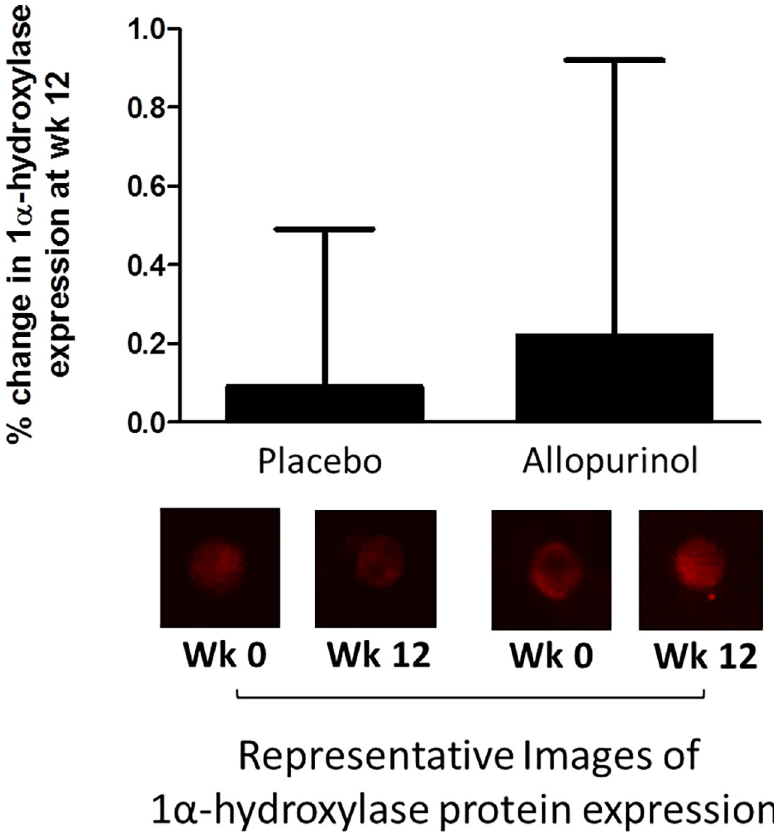
Fig 1. Treatment with allopurinol for 12 weeks was not associated with increased expression of 1 α - hydroxxylase protein compared to placebo (p value for generalized linear mixed model = 0.59). The figures represent change in the expression of the protein from baseline by study group. Values for each sample were reported as arbitrary units and represent ratios of endothelial cell protein expression to human umbilical vein endothelial cell (HUVEC) expression in order to account for any variation in the staining procedure.